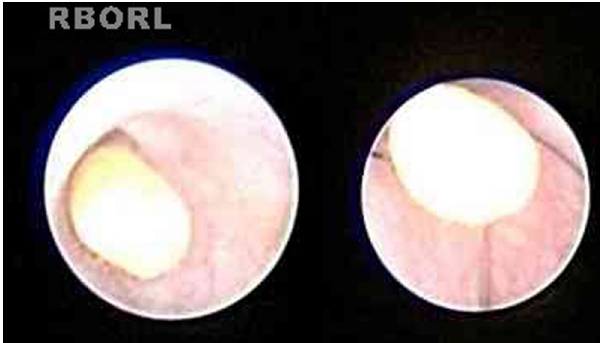
Sialendoscopic view of a stone and its removal with mini basket